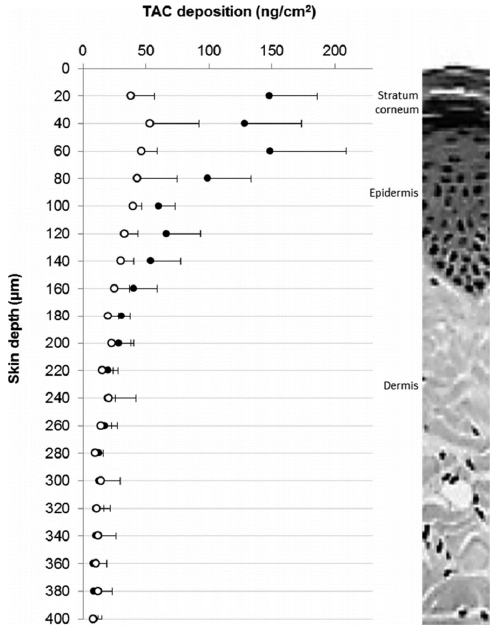
Figure 8. Cutaneous distribution profile of TAC in the upper layers of human skin (total depth of 400 µm and a resolution of 20 µm) after a 12 h application of the 0.1% micelle formulation (close dots) and Protopic (0.1% w / w ) (open dots). Reprinted with permission from [21]. Copyright American Chemical Society 2014.